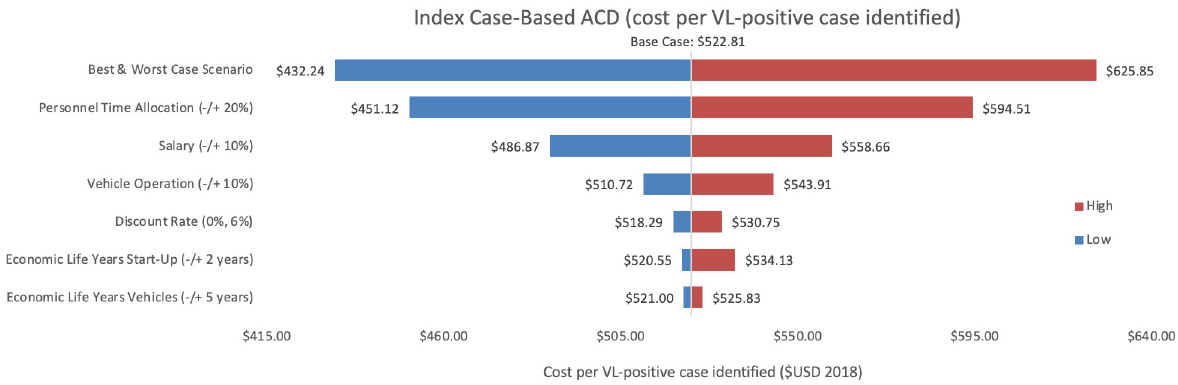
Fig 7. Sensitivity analysis of index case-based ACD per VL-positive case identified. Variations in index case-based ACD cost per VL-positive case identified in Bihar during 2018.